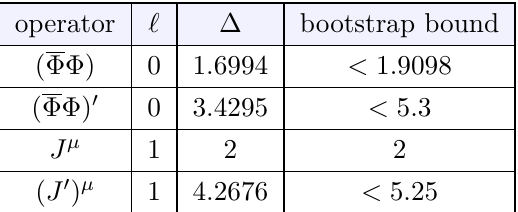
Table 1 . Comparison between the actual dimension of the operators and their bounds from boot- strap. (ΦΦ) and (ΦΦ) 0 are the lowest dimension and second-lowest dimension scalar superconformal primaries in the Φ × Φ OPE, respectively. J µ is the R -current, while ( J 0 ) µ is the second-lowest dimension spin-1 superconformal primary in the Φ × Φ